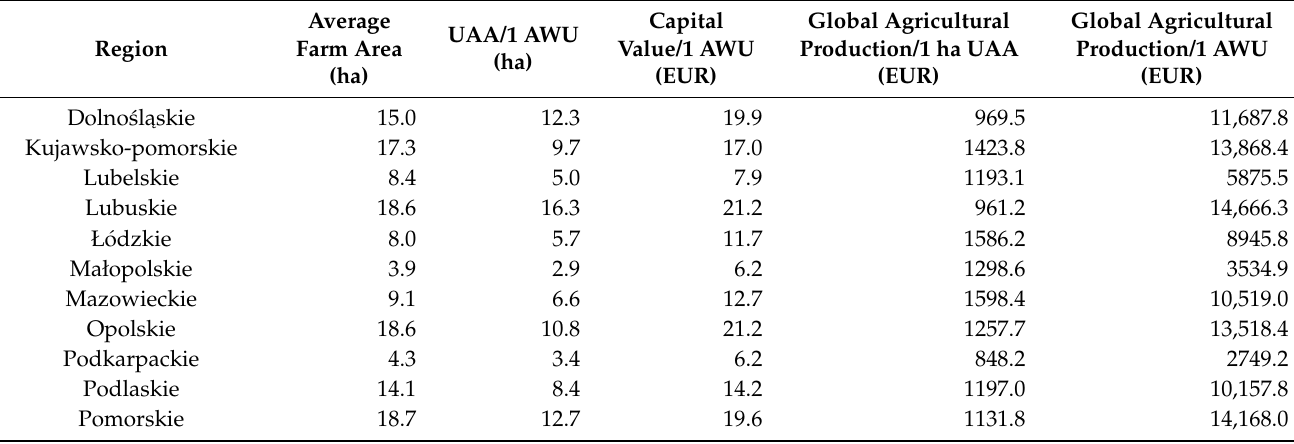
Table 1. Characteristics of agricultural potential and productivity in the Polish